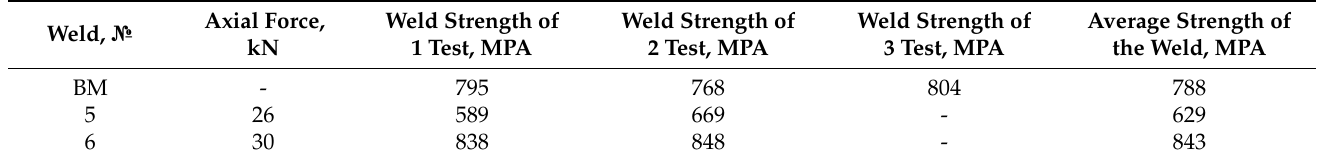
Figure 8. Stress – strain curves for Ti-4Al-3Mo-1V welds obtained with different FSW parameters. The tensile test results for Ti-4Al-3Mo-1V/Ti-6Al-4V welded joint specimens are presented in Table 6. The data indicate that the increase in the axial load on the tool had a positive effect on the weld strength characteristics. Table 6. Effect of FSW parameters on the strength of the Ti-4Al-3Mo-1V — Ti-6Al-4V joint .